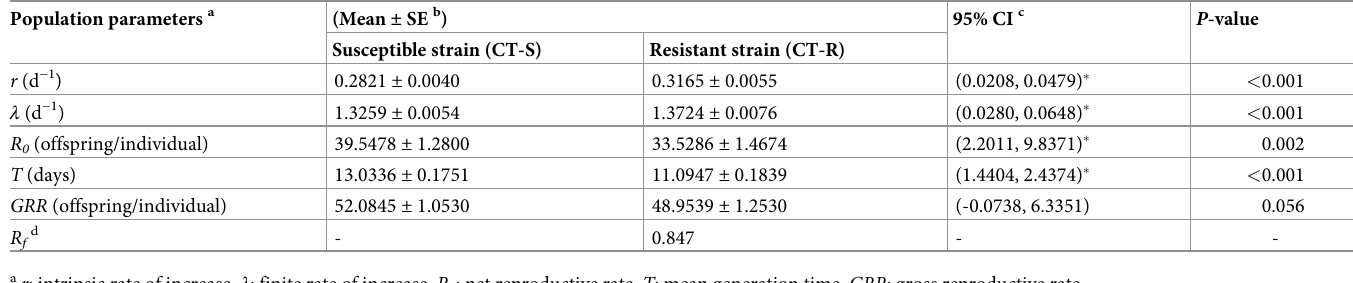
Standard errors (SE) were estimated using the bootstrap technique with 100,000 re-samplings. c Difference between strains were compared with paired bootstrap test. If the CI includes 0, there is no difference at 5% level. d R f = R 0 of the resistant strain (CT-R)/ R 0 of the susceptible strain (CT-S). � Significant differences between resistant strain (CT-R) and susceptible strain (CT-S) at P = 0.05 level, paired bootstrap test using TWOSEX MS chart